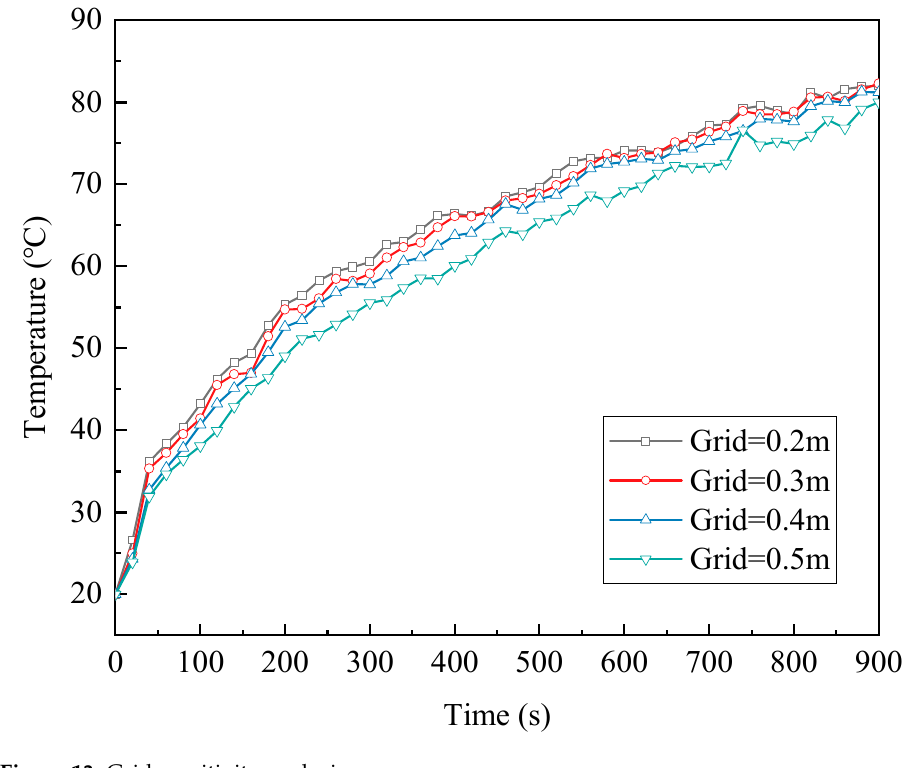
Figure 13. Grid sensitivity analysis.